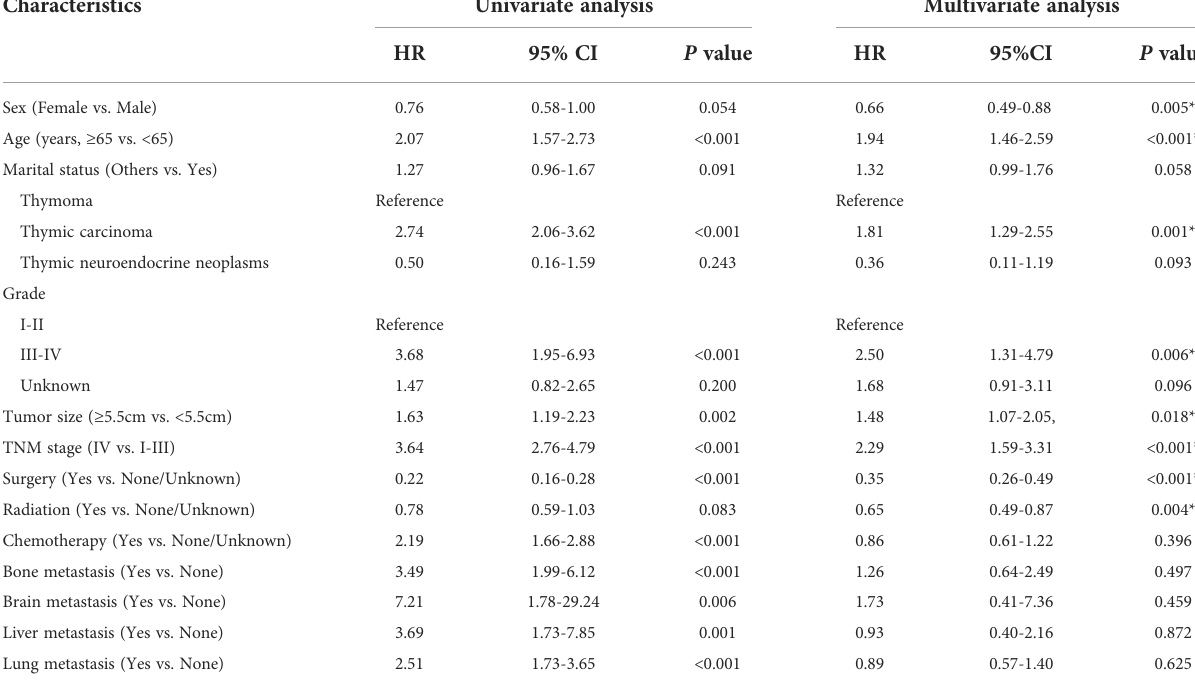
TABLE 2 Univariate and multivariate Cox analyses on variables for the prediction of OS of patients with TETs.